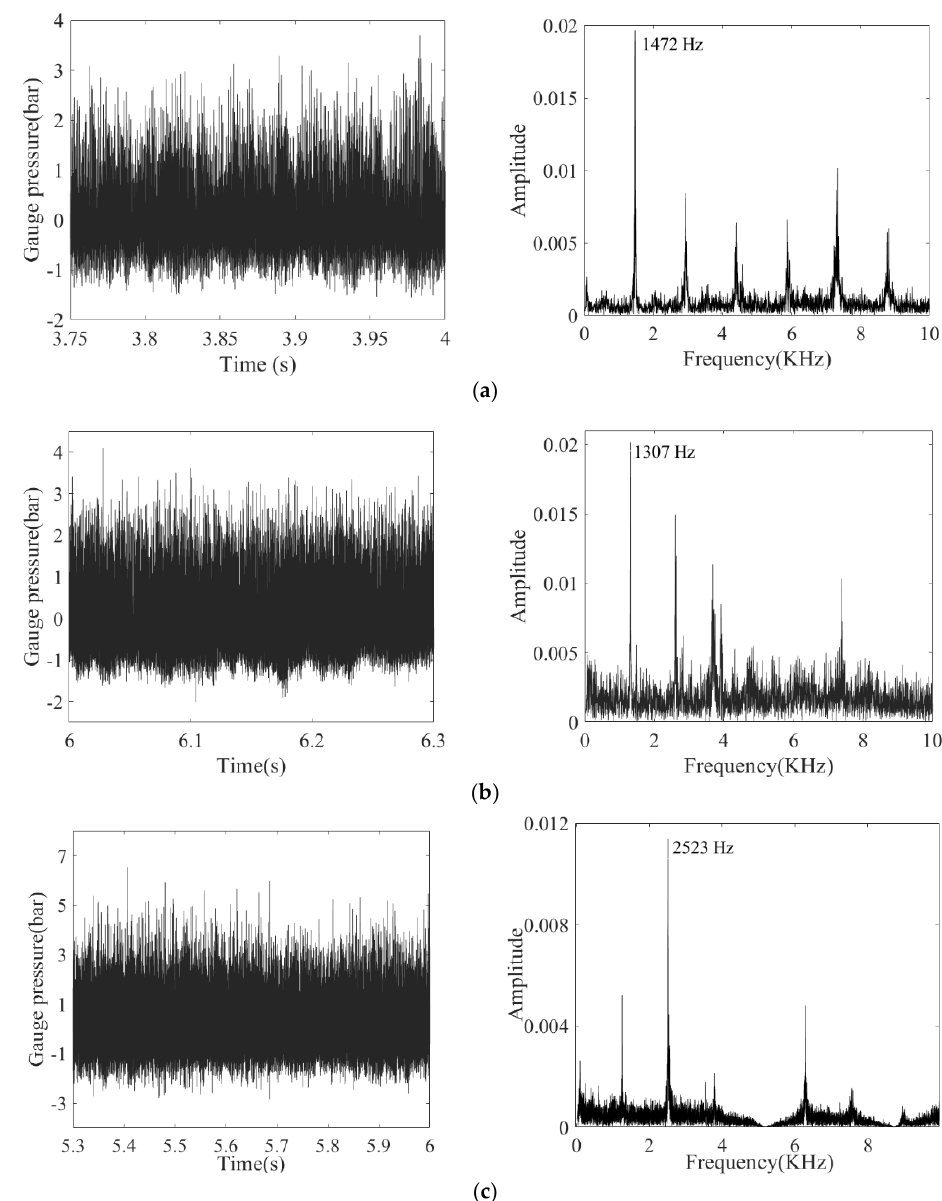
Figure 2. Local high − frequency pressure and FFT results of ( a ) Test A6, ( b ) Test A7, and ( c ) Test A5. The dominant frequency of A6 is 1472 Hz, and the corresponding propagation velocity of the detonation wave is 924.9 m/s, thus indicating the single-wave mode. When the mass fraction of hydrogen drops from 12.3% to 10.2%, the frequency of detonation wave of A7 also drops to 1307 Hz, and the corresponding wave velocity is 819.3 m/s. The detonation wave still propagates in single-wave mode, but the wave velocity decreases by about 11.4%. When the hydrogen mass fraction is further reduced to 8.8%, it is found that the detonation wave of A5 becomes a dual-wave collision mode, with a dominant frequency of 2523 Hz and a wave speed of 792.6 m/s, which is about 14.3% lower than that of A6. With the decrease of the mass fraction of hydrogen, the propagation speed of deto- nation wave continues to decrease because the chemical reaction activity of hydrogen is higher than that of kerosene. This is consistent with Bykovskii’s results [28]. The decrease of the mass fraction of hydrogen will reduce the activity of reactants, thereby decreasing the velocity of the detonation wave. The dual-wave collision mode appears in operating